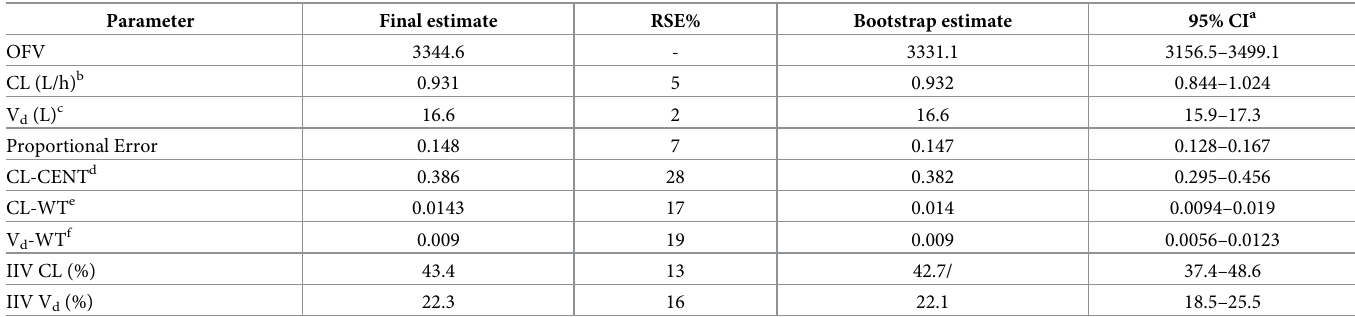
Table 2. Parameter estimates of final model compared with bootstrap